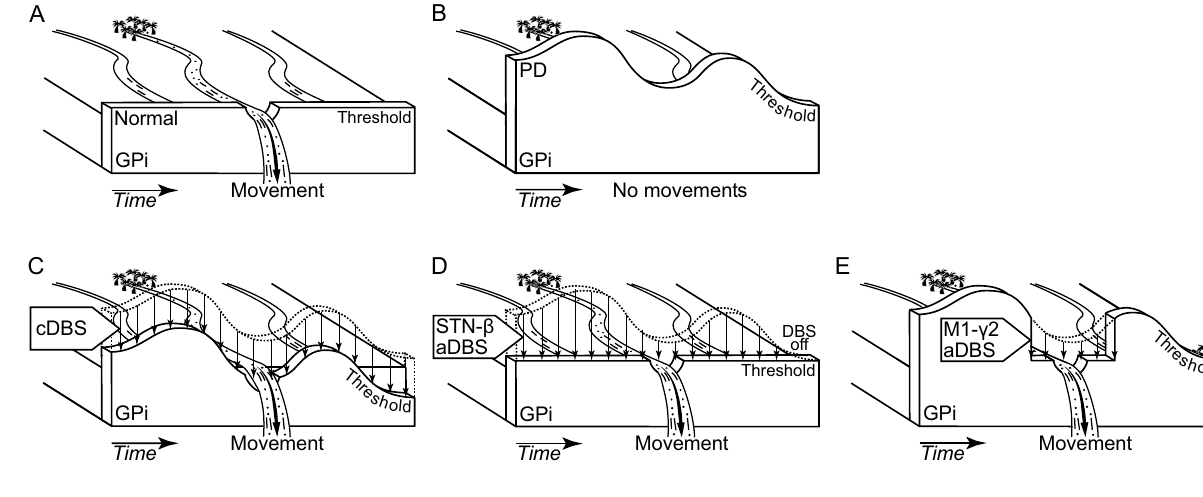
Figure 1. The “dam model” of basal ganglia functions 28 and the expected effects of STN-DBS using constant and adaptive paradigms. ( A ) Normal state: In the healthy state, only the selected motor plans pass over the threshold of the internal pallidal (GPi) function, causing the intended movement, while other plans are blocked. ( B ) Parkinson’s disease (PD) condition: In parkinsonism, the threshold of the GPi function is elevated, which causes the blockade of all motor plans, resulting in hypokinesia. ( C ) cDBS in PD: Constant deep brain stimulation (cDBS) delivers constant stimulation to the subthalamic nucleus (STN), continuously lowers the threshold of the GPi function, and allows the motor plans to cause the intended movements. ( D ) STN-β aDBS in PD: Adaptive DBS (aDBS) is modulated by β activity in the STN, which is a biomarker of hypokinesia. STN-β aDBS delivers stimulation when hypokinetic state occurs, temporary lowers the threshold of the GPi function, and increases the likelihood for selection of motor plans during this time window. ( E ) M1-γ2 aDBS in PD: aDBS is modulated by γ2 activity in the primary motor cortex (M1), which is a biomarker of movement-related activity. M1-γ2 aDBS delivers stimulation when motor plans are presupposed being generated in the M1, lowers the threshold of the GPi function, and increases the likelihood for selection of motor plans in this time Deep brain stimulation (DBS) targeting the subthalamic nucleus (STN) successfully treats motor symptoms related to Parkinson’s disease (PD) and dopaminergic replacement therapy, i.e., bradykinesia, tremor, and